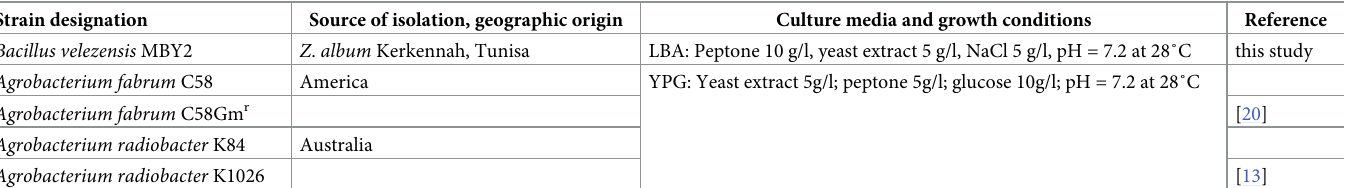
Table 1. Bacterial strains used in this